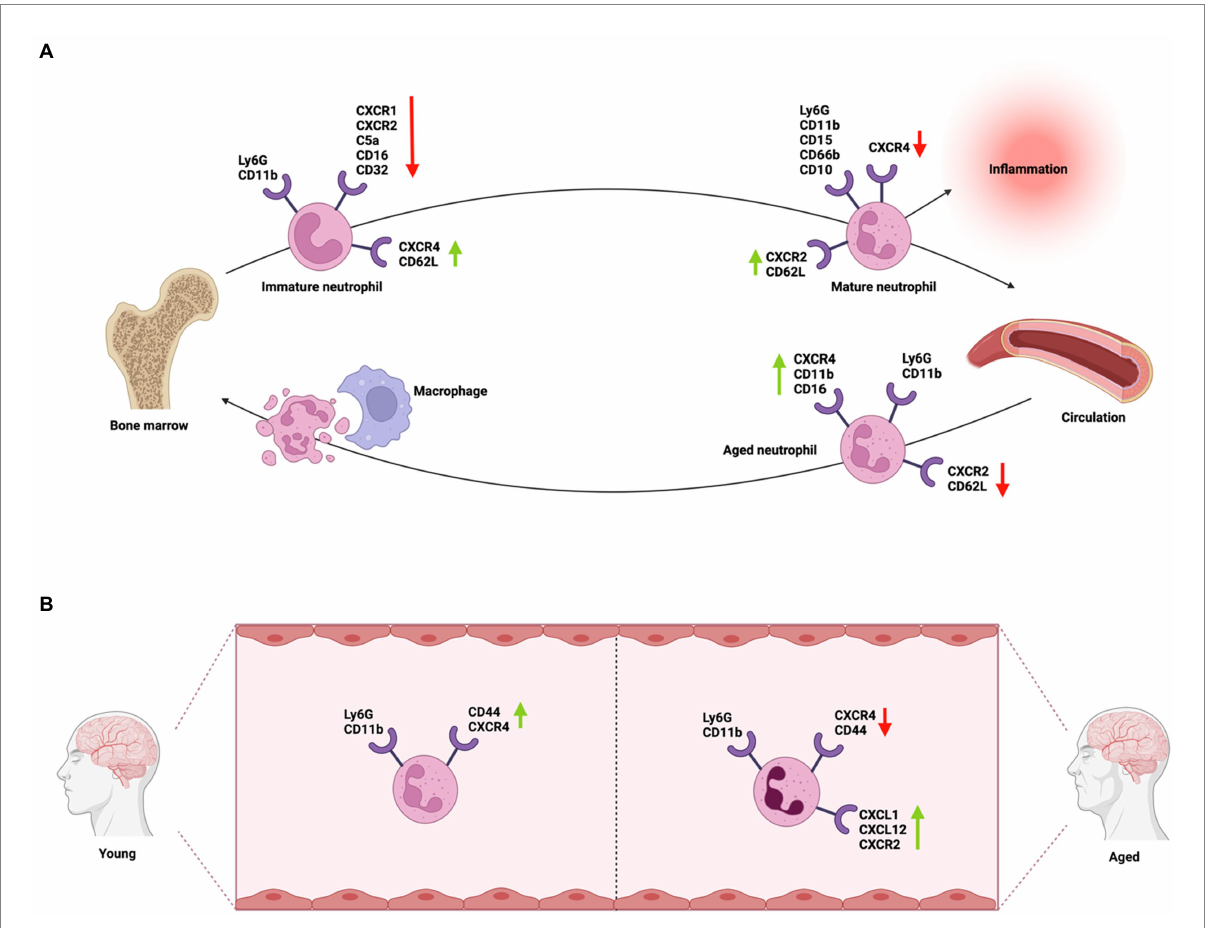
FIGURE 2 Neutrophil phenotypic differentiation during circulation and neutrophil phenotypic heterogeneity in aging. (A) Immature neutrophils are produced in the bone marrow, where they express either CXCR4 and CD62L on the cell surface to remain in the bone marrow or CXCR2 to be released